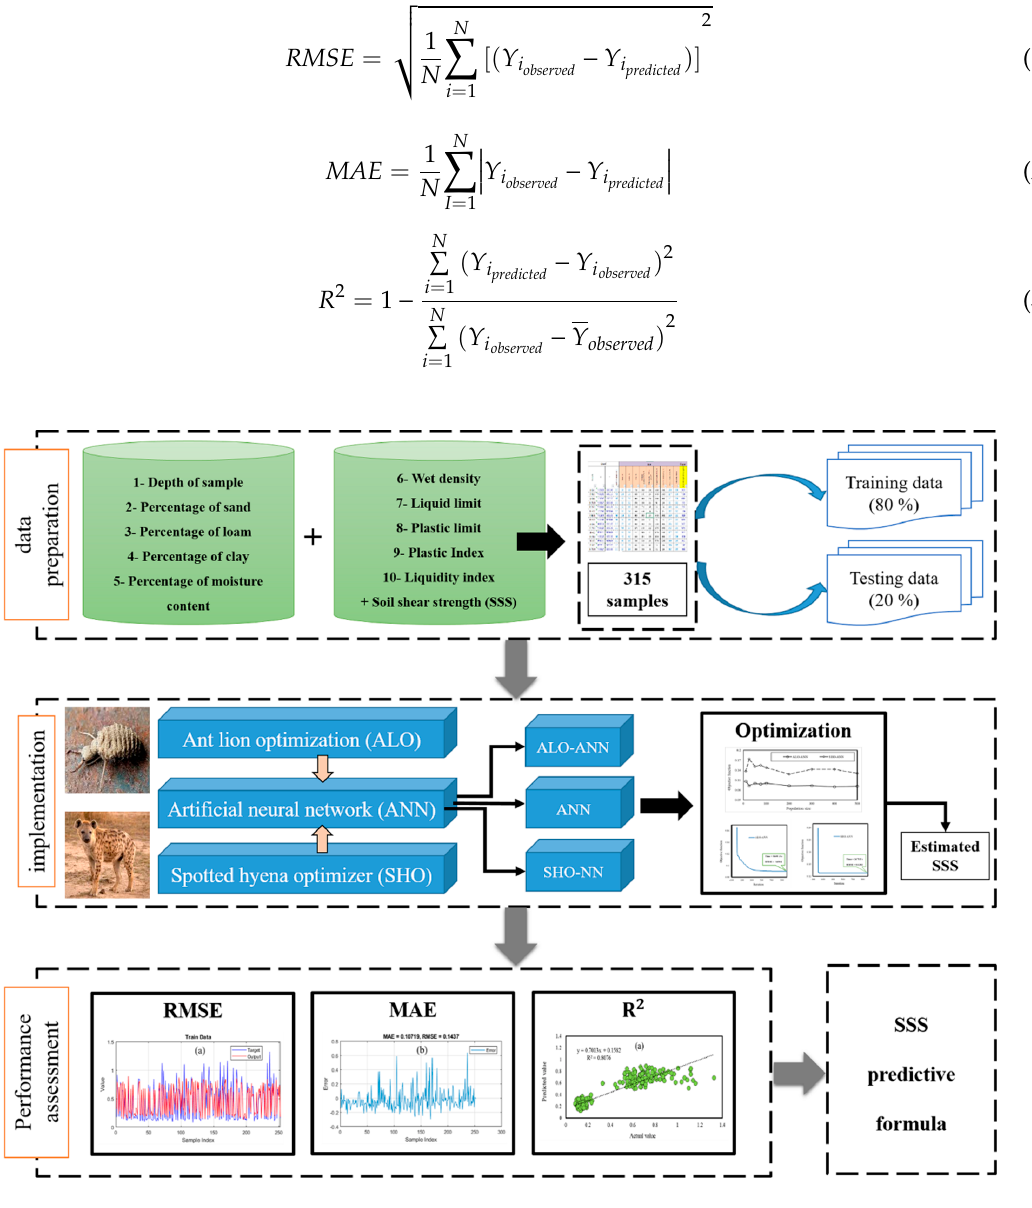
Figure 1. The steps taken for soil shear strength (SSS) simulation in this study.